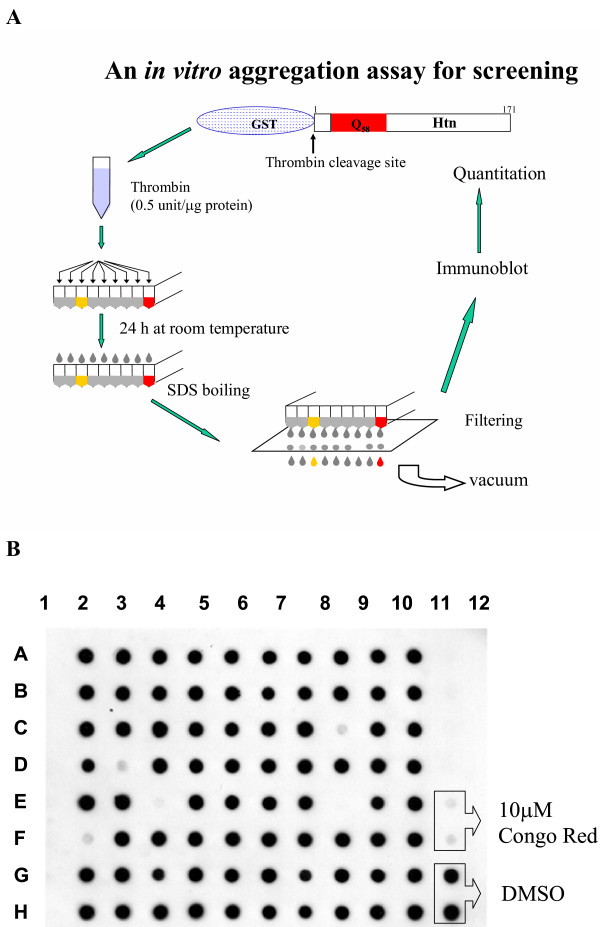
Schematic diagram of the aggregation screening assay (A) and typical results (B) A: Scheme of an in vitro mutant huntingtin aggregation assay modified for drug screening. In the primary screening, the mixture of fusion protein, GST-Q58-Htn (20 μg/ml) and Thrombin (0.5 unit/μg protein) was immediately distributed into the 96-well plates containing diluted compounds at 40 μl/well. The final concentration of the small compounds is 100 μM. 10 μl of 10% SDS/50 mM 2-mercaptoethanol was added into each well to stop the reaction after 24 hours incubation at room temperature. The aggregates were separated by filtering through a cellulose acetate membrane (0.2 μm). Immunoblotting was done with a specific anti-huntingtin antibody, HP1, followed by incubation with peroxidase conjugated anti-rabbit antibody. The signals of the retained aggregates were scanned and quantified. In the secondary screening, compounds tested positive in were tested at 10 μM and a 45-minute incubation at room temperature was followed after mixing the protein and enzyme. B: A typical immunoblot of the huntingtin aggregation inhibitor screening. The aggregates retained on the membrane were visualized by ECL. The intensity of dot reflects the amount of aggregates. The blot shows the positions of each drug in a 96-well plate. Congo Red: positive control (row E, column 12 and row F, column 12). DMSO: negative control (row G, column 12 and row H, column 12). Drugs in wells F2, E4, E9 and D3 are huntingtin aggregation inhibitors.